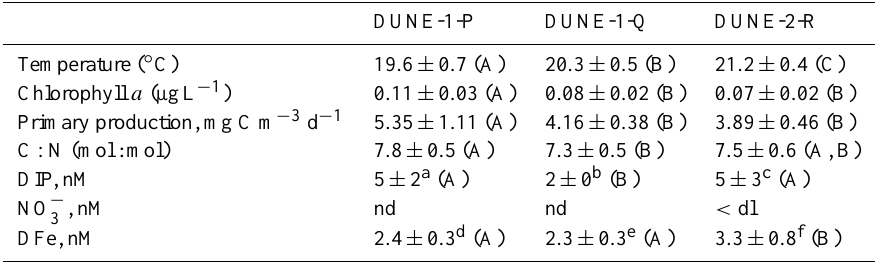
Table 2. Initial temperature and biological and chemical properties of seawater before seeding in experiments DUNE-1-P, DUNE-1-Q and DUNE-2-R (average in the Dust-meso, Control-meso and out). DIP: dissolved inorganic phosphorus; dl: detection limit (30nM for NO − nd: no data. Data for temperature, chlorophyll a , DIP, NO − and DFe are the means at 0.1, 5 and 10m in depth. Data for primary production 3 and the C : N ratio are the means at 0.1 and 5m in depth for the DUNE-1-P and DUNE-1-Q experiments, and at 5m in depth for the DUNE- 2-R experiment. Means that were not significantly different for a given parameter between the different experiments ( p > 0 . 05) are labeled with the same letter (in